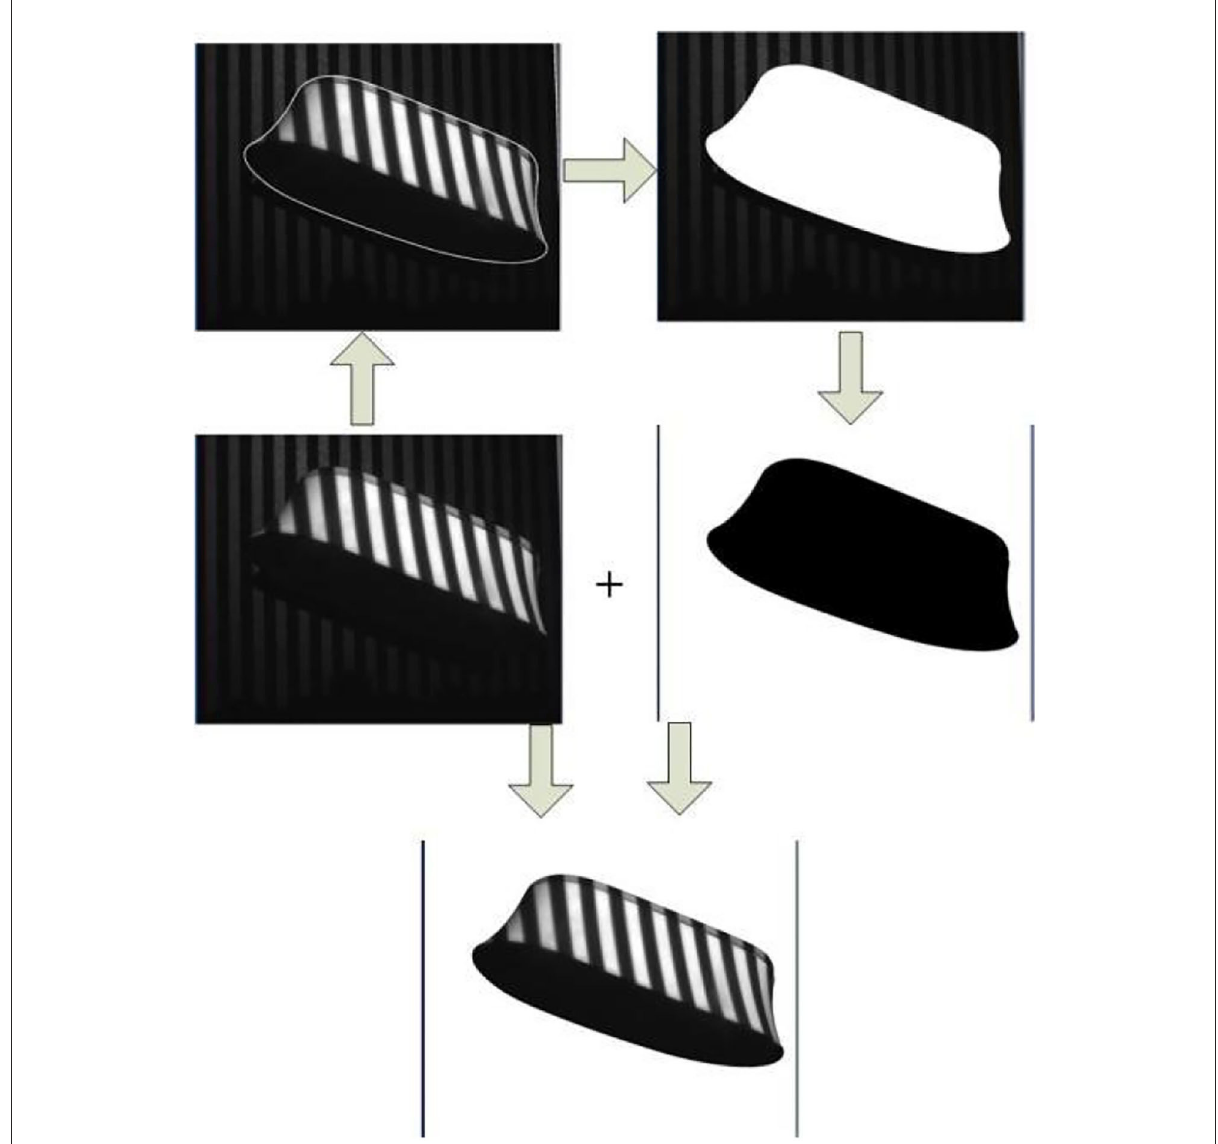
FIGURE9 Remove the